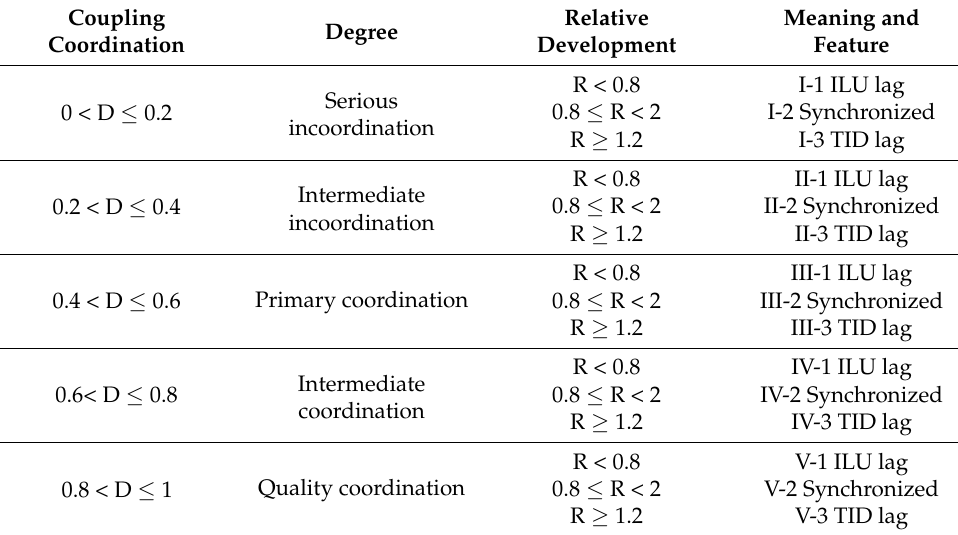
Table 2. Coupled coordination classification system of LIU and